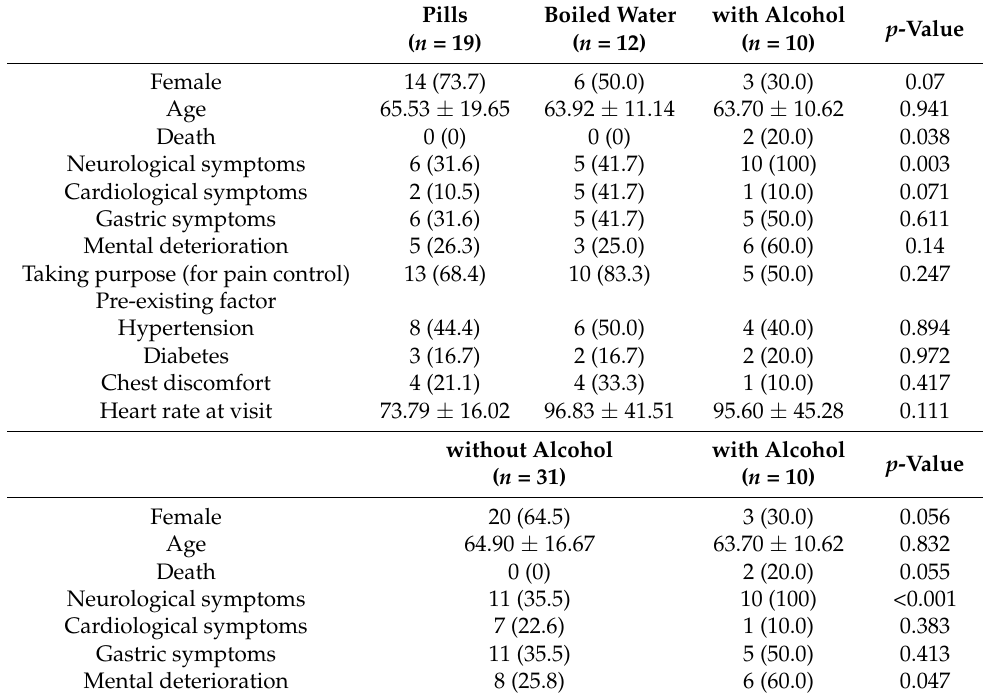
Table 2. General characteristics of processing